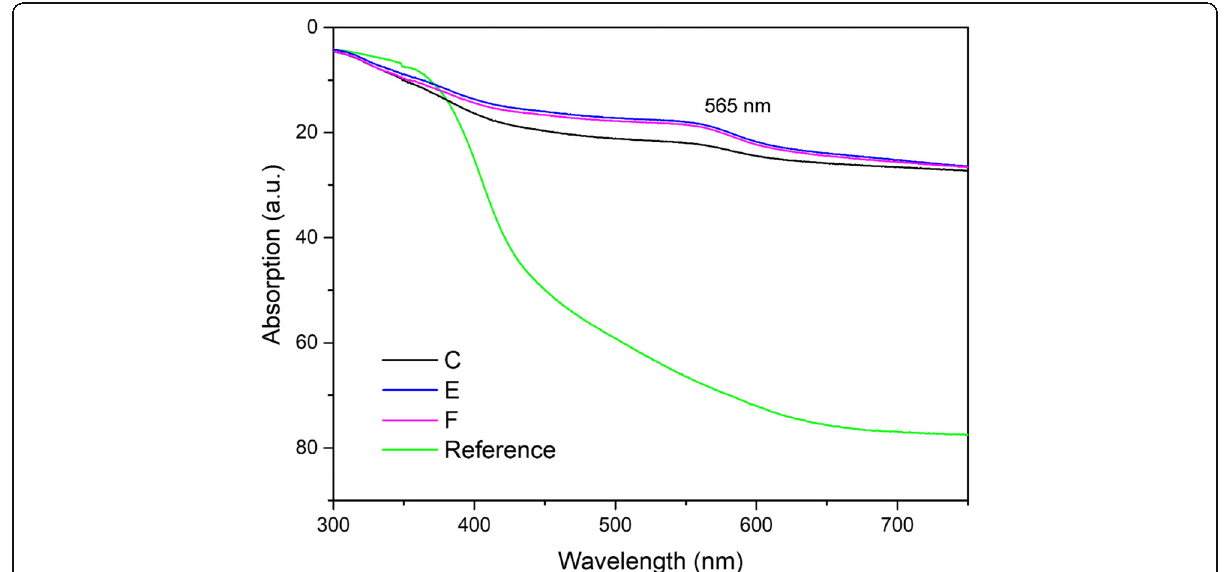
Fig. 8 UV-Vis spectra of original wood and hybrid wood materials